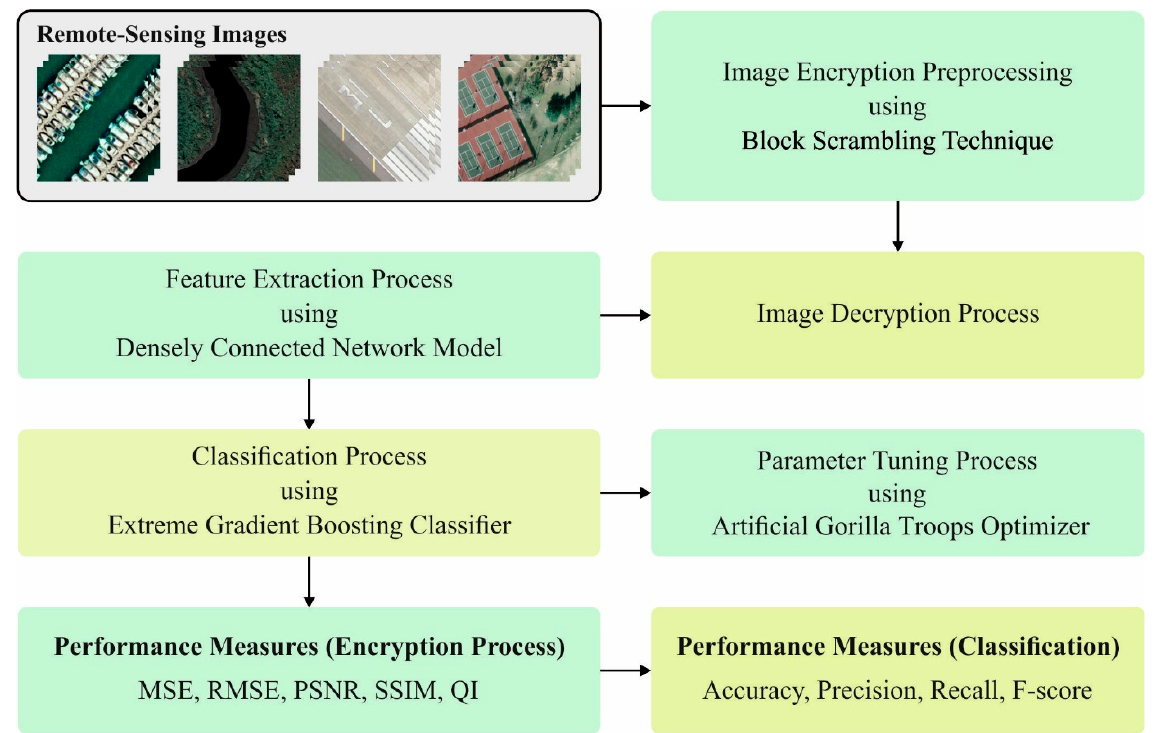
Figure 1. Block diagram of BSBE-PPODLC system.